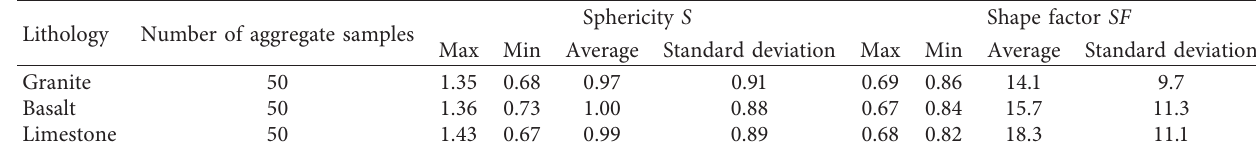
Table 5: Shape feature of the aggregate samples.